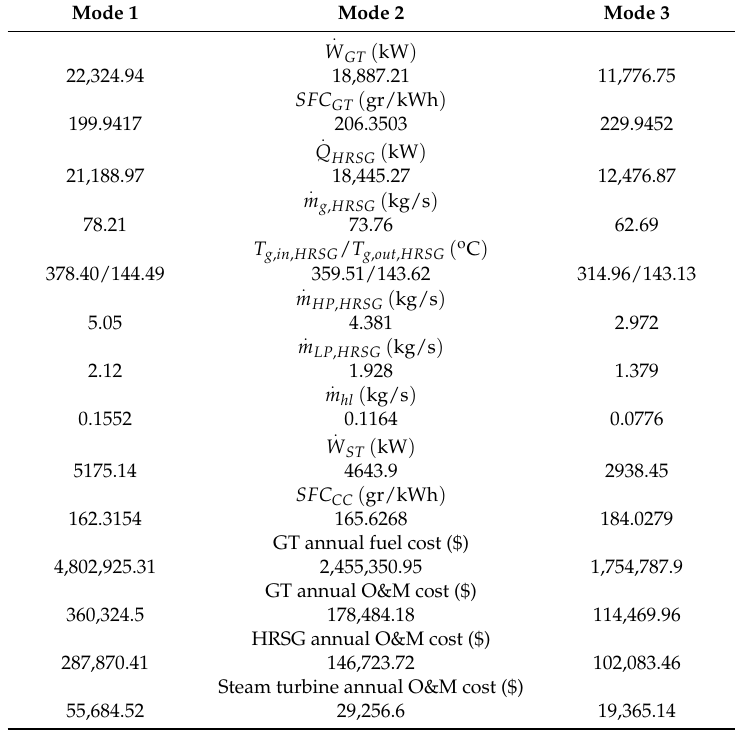
Table 8. Operational technical and economic characteristics for the system with gas turbine type (b) and fuel